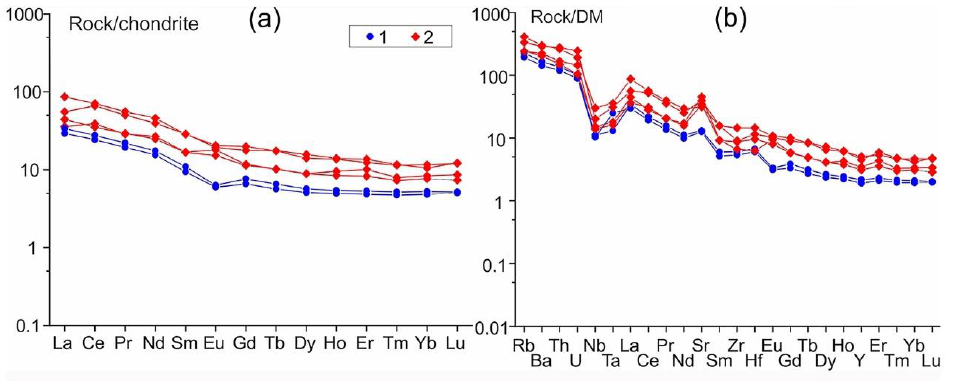
Figure 15. Spectrum of REE in rocks of the Imandra – Umbarechka Complex and Ostrovsky massif ( a ) normalized to chondrite [33]; spider-diagram ( b ) normalized to DM [32]. 1: The Imandra – Umbarechka Complex; 2: The Ostrovsky massif.